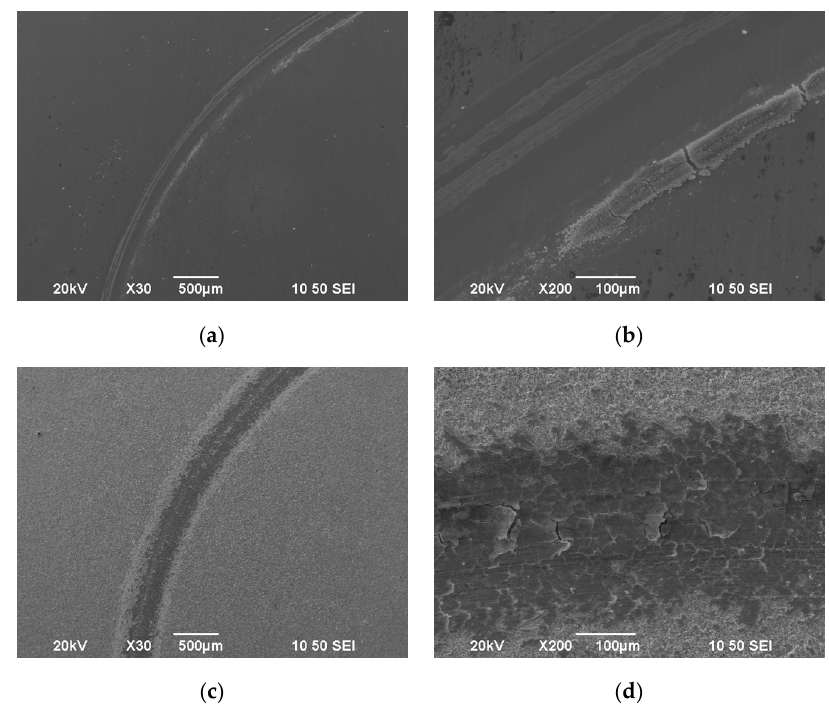
Figure 13. SEM surface micrographs of wear track of ( a , b ) pure SnNi coating (Sample I), ( c , d ) composite coating Sn–Ni/N,S-TiO 2 (Sample B).